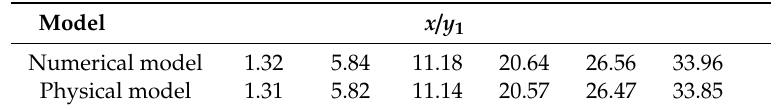
Table 4. Location of the vertical profiles measured for the void fraction distribution